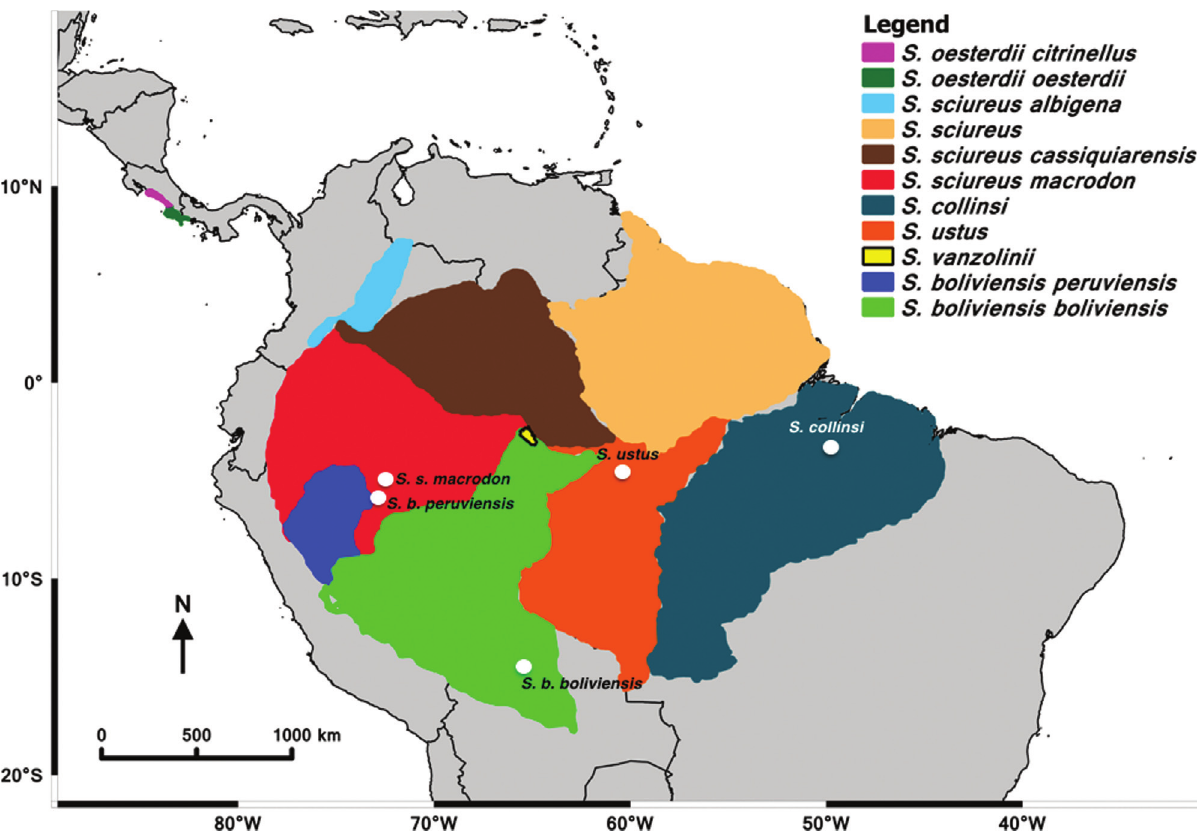
Figure 1 - Map showing the geographical distributions of Saimiri species and the original sites where each one of the five populations studied was found. The majority of S. b. boliviensis specimens where captured in Santa Cruz de La Sierra, Bolivia (region in green) and later transported to CAPRIM in Ar- gentina. Those from S. b. peruviensis (region in blue) and S. sciureus macrodon species (region in red) where captured in the vicinity of Iquitos, Peru, and then transported to CRCP/IVITA in Iquitos. S. ustus (region in orange) and S. collinsi specimens (region in aquamarine blue) were captured and sampled in the